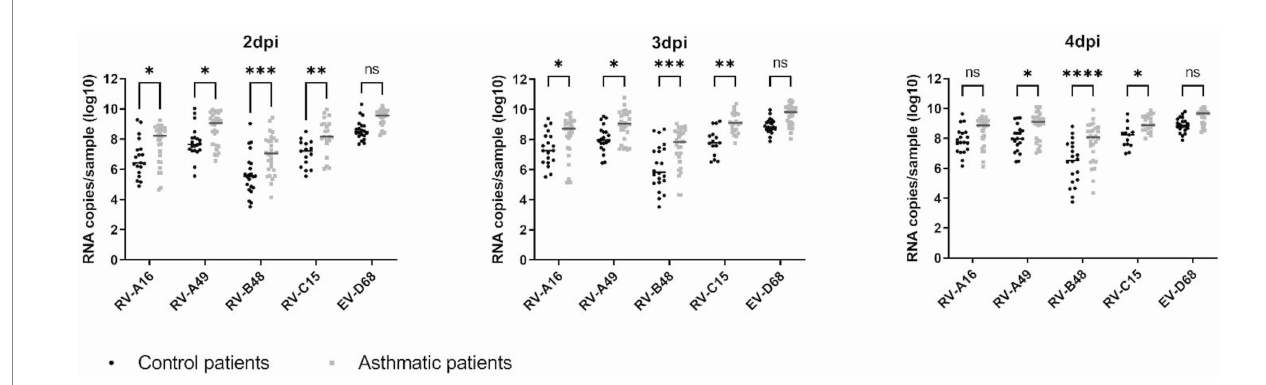
FIGURE 1 Virus production at the apical side of ALI culture of reconstituted HAE derived from non-asthmatic (control) or asthmatic patients represented as scatter plots with medians. Twelve control and 14 asthmatic donors were included (Supplementary Table S1). Statistically significant differences between HAE from asthmatic or control donors are indicated. ns: non-significant, * p < 0.05, ** p < 0.01, *** p < 0.001, and **** p <